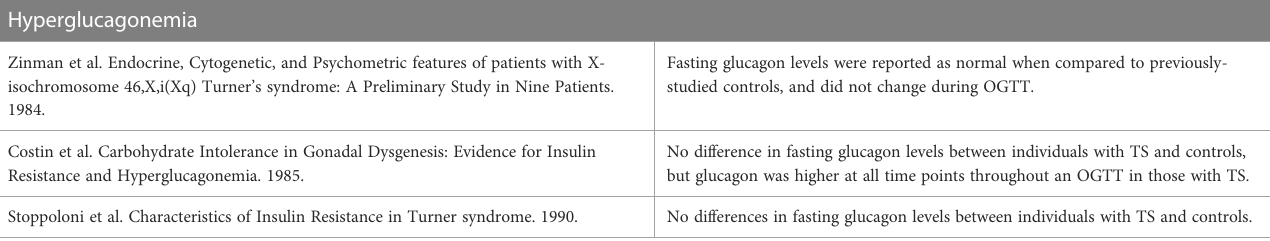
TABLE 6 Summary of key studies evaluating hyperglucagonemia as a potential mechanism contributing to TS-associated hyperglycemia. Hyperglucagonemia